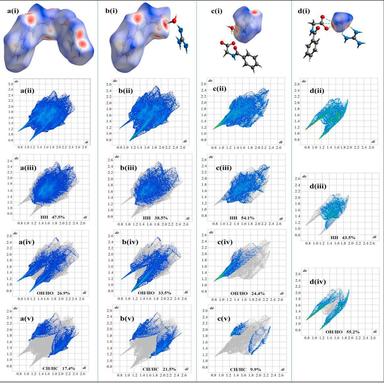
Hirshfeld Surface on (a) GuHM (b) Hippurate Anion (c) Guanidinium Cation (d) Water molecule.